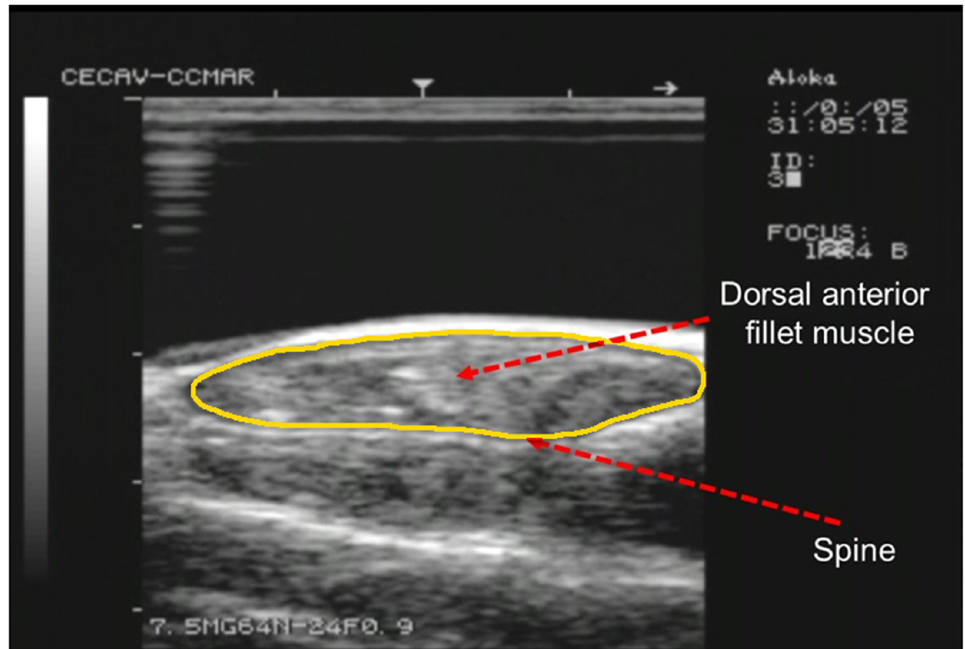
Figure 1. Example of a RTU cross-sectional image acquired with a 7.5 MHz probe at S 3 position. Arrows indicate the spine and right dorsal fillet muscle. The outline of the fillet section is highlighted in yellow.